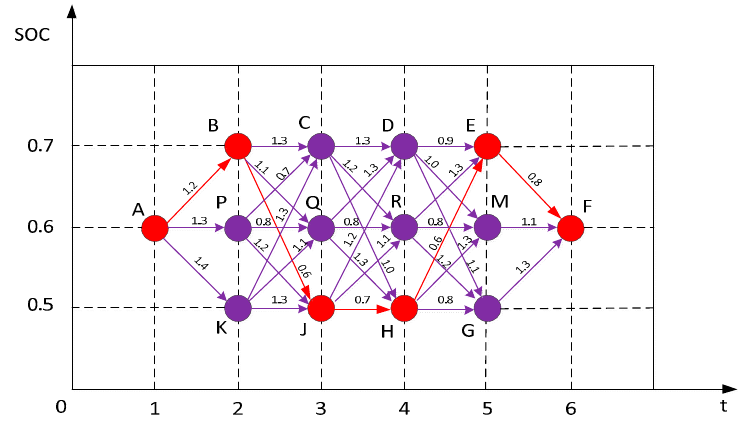
Figure 5. The principle of dynamic programming.